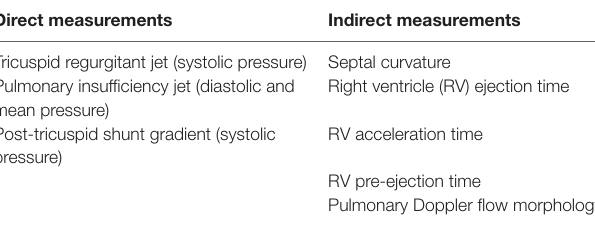
TAble 1 | Detection of elevated pulmonary arterial